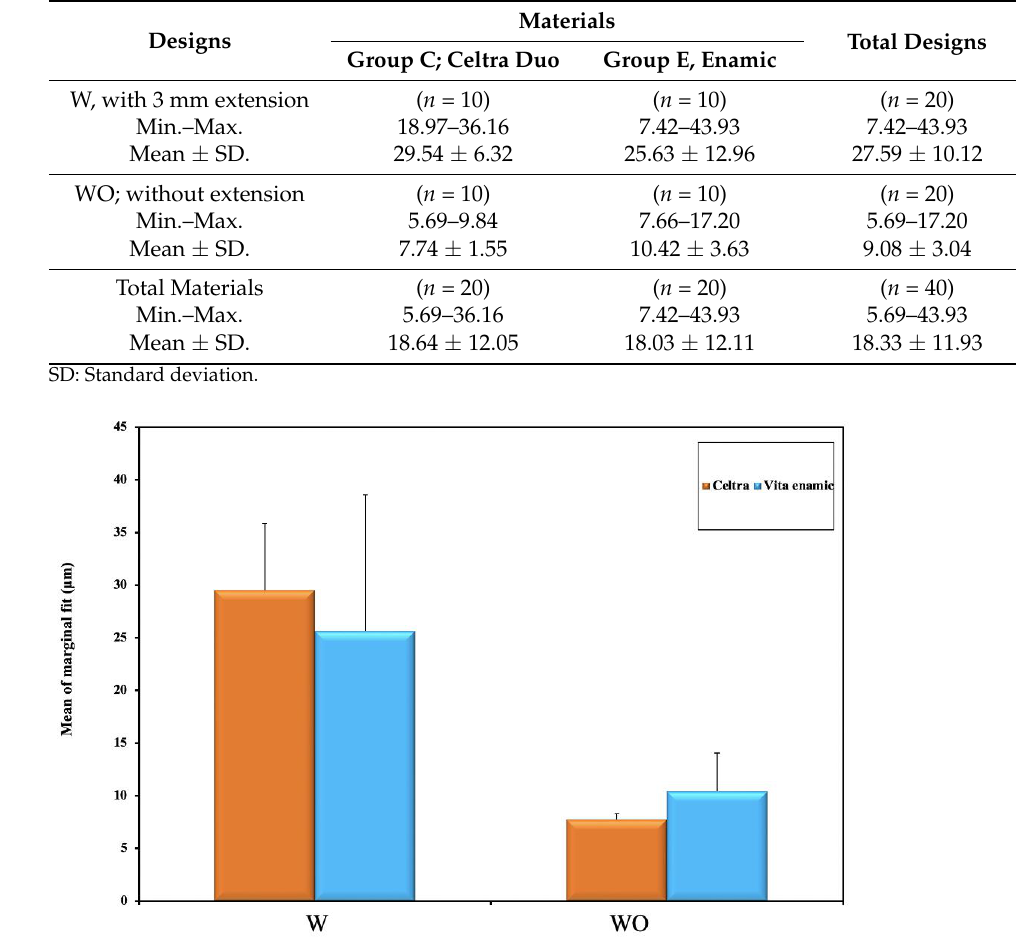
Table 2. Measurements of marginal fit ( μ m) according to the two studied materials and preparation designs.